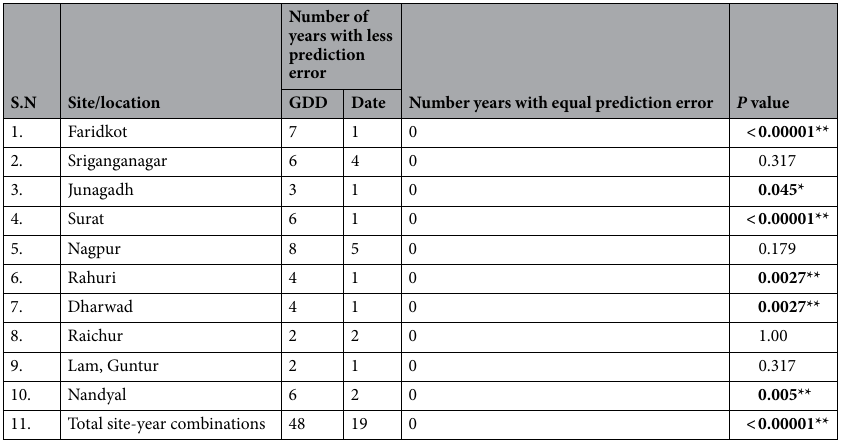
Table 3. Number of site-year combinations for pink bollworm showing less or equal prediction errors for peak moth catches based on growing degree days (GDD) or calendar dates when compared to a mean value based on n-1 years at each site (Chi 2 test applied @ df = 1). *Chi 2 value significant at 0.05% level of significance. ** Chi 2 value highly significant at 0.05% level of significance.